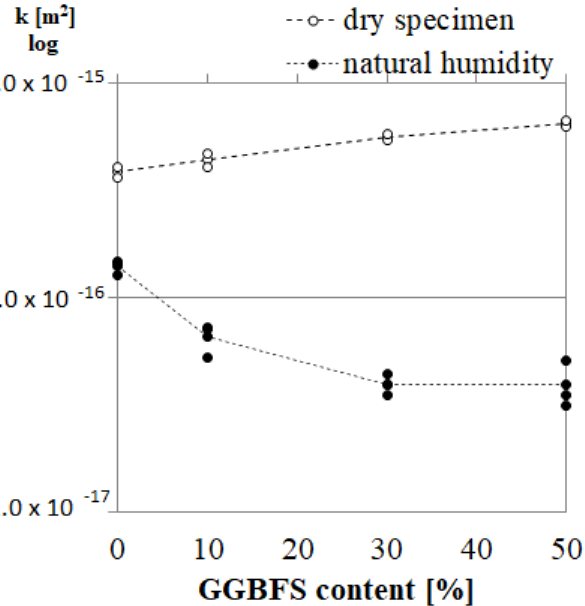
Figure 7. Permeability coefficient of AA mortars at ambient humidity and dry conditions relative to GGBFS content.